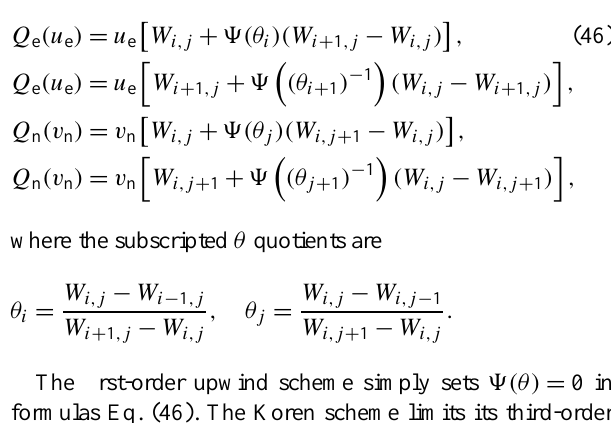
Figure 4. Numerical schemes Eqs. (44) and (49) use a grid-point- centered cell. Velocities, diffusivities, and fluxes are evaluated at staggered-grid locations (triangles at centers of cell edges) denoted by compass notation e,w,n,s . State functions W,W til ,P are lo- cated at regular grid points